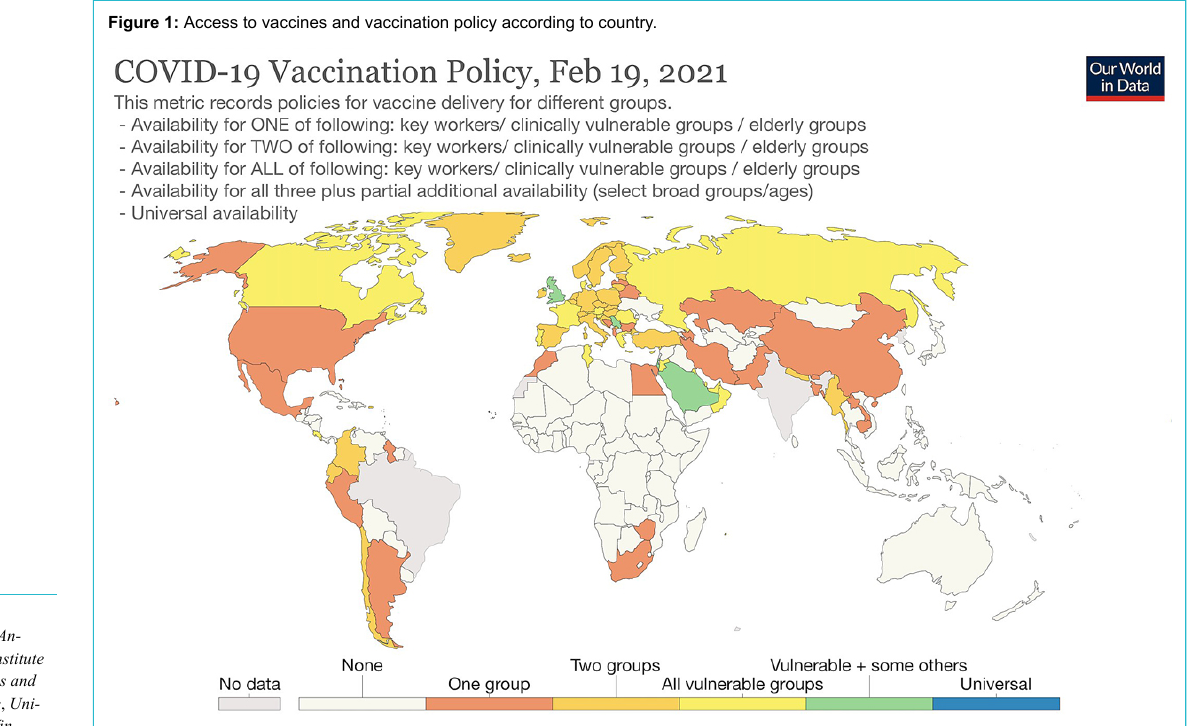
Figure 1: Access to vaccines and vaccination policy according to